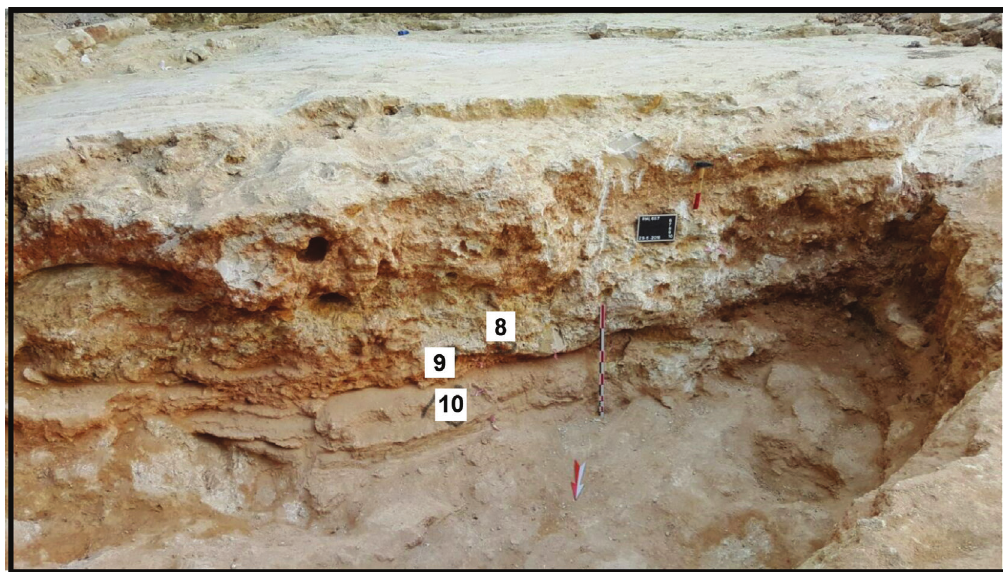
site 2 excavated bedrock that shows the two stages shore structure, from base: layer 10 of backshore sediments; layer 9 of beach-rock sediments; subangular cobble sized lithoclasts 8 at base of layer 9. The backdrop of field of view is the Paleogene–Neogene outcrop.